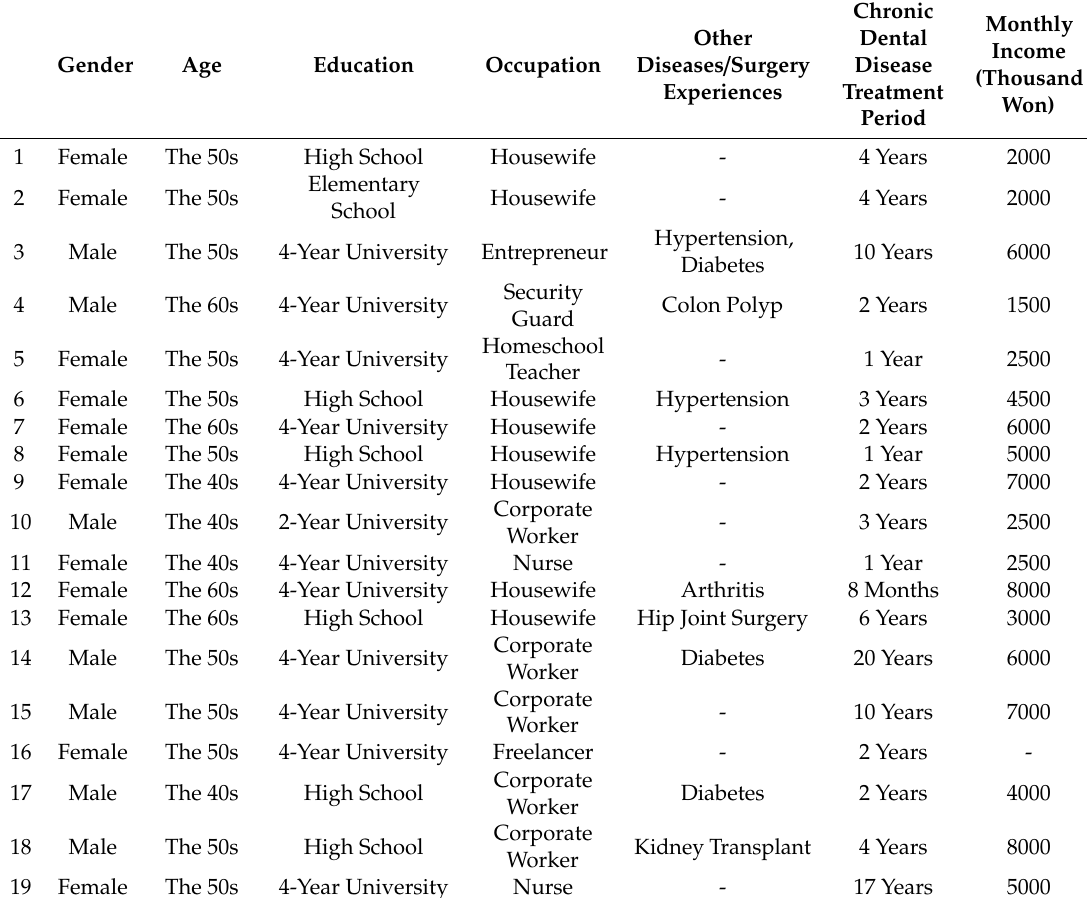
Table 1. Sociodemographic characteristics of